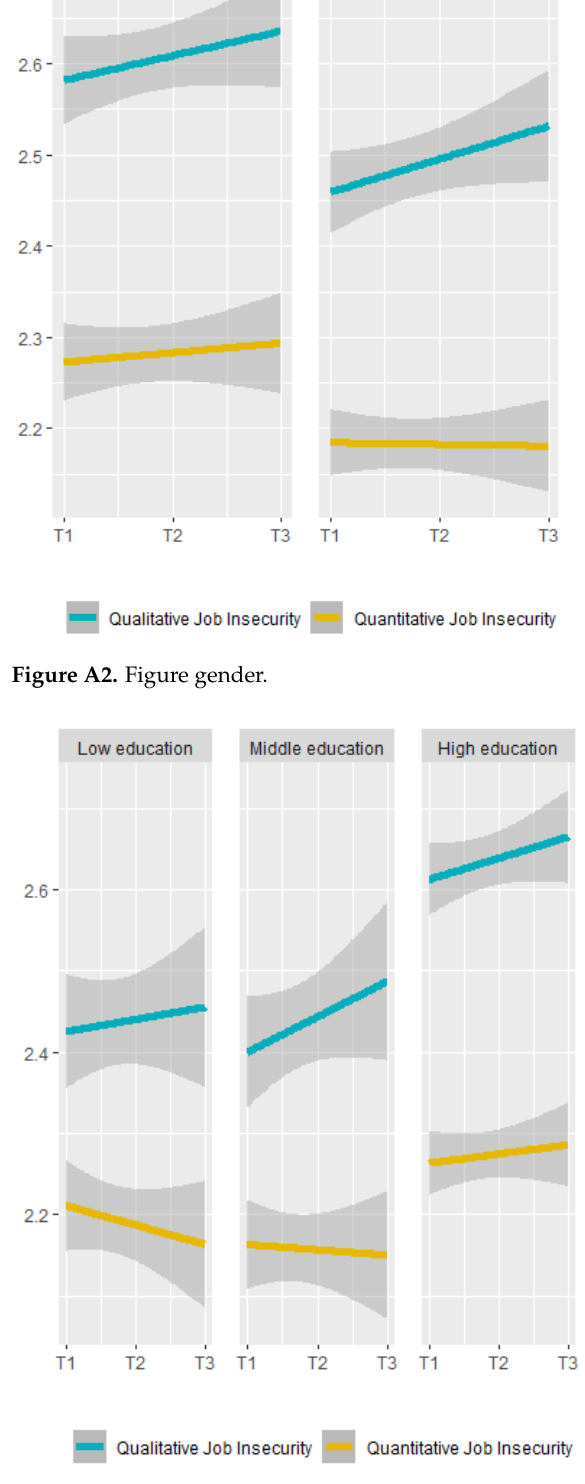
Figure A3. Level of education.